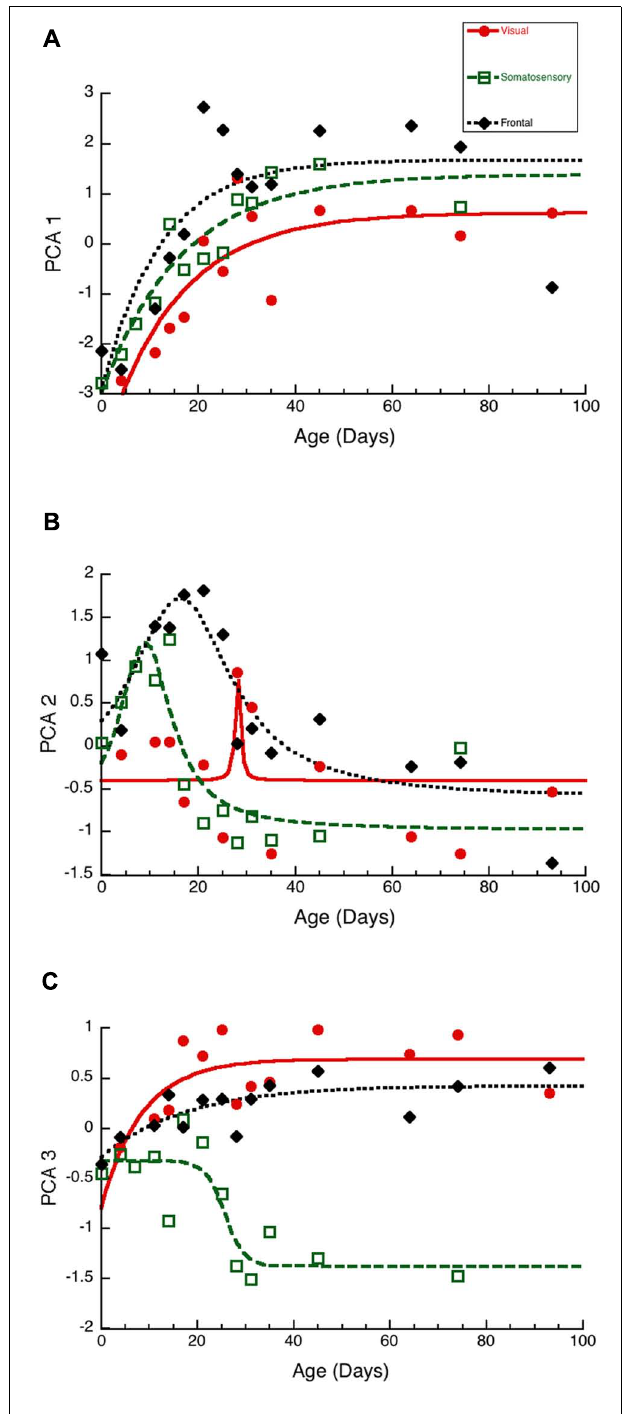
FIGURE 6 | Developmental changes in the three principal components in visual (red dots, solid line), somatosensory (green squares, dashed lines), and frontal (black diamonds, dotted line) cortex. (A) Principal component 1. Exponential decay functions were fit to the data for each areas, adult levels are defined as 3 τ . Principal component one reached adult levels in visual at P45 (3 τ = 44.7 ± 18.3; R = 0.85, p < 0.0001), somatosensory at P50 (3 τ = 49.6 ± 14.8; R = 0.94, p < 0.0001), and frontal at P37 (3 τ = 36.5 ± 19.0; R = 0.78, p <